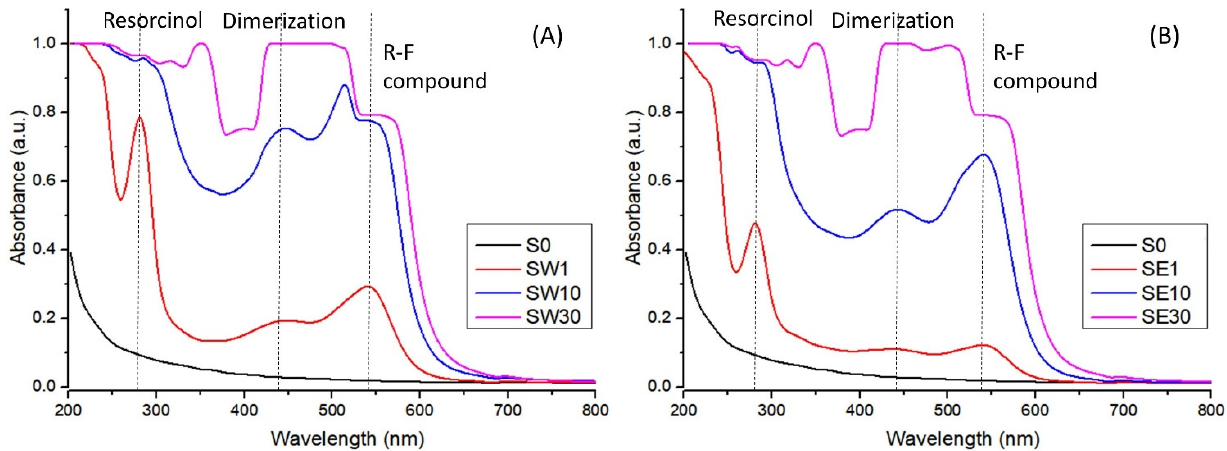
Figure 3. UV–Vis spectra for PFSA and PFSA–RF samples using water ( A ) and an ethanol–water mixture ( B ) as the solvent in the impregnation process.